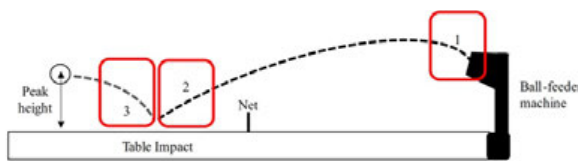
Figure 1. Mechanical Testing Set-up; red zones signify areas of data